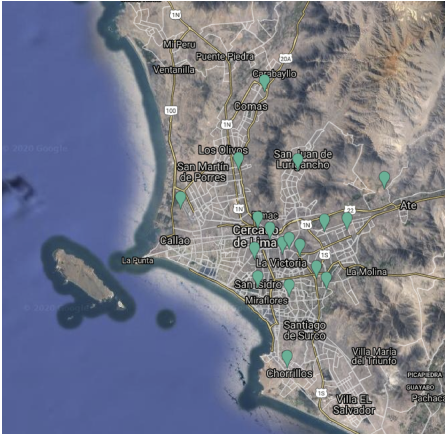
Figure 1. Map from Lima, Peru, showing the location of the 18 areas selected as described in Section 2.1.2. The image shown corresponds to approximately 49 km by 49.5